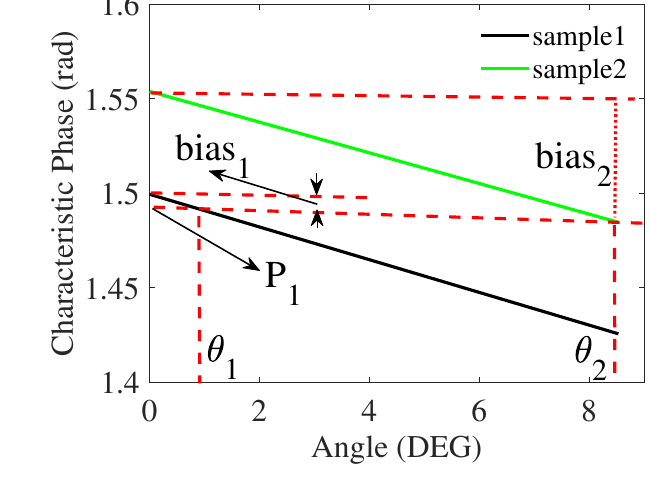
Figure 9. Schematic of the bias.